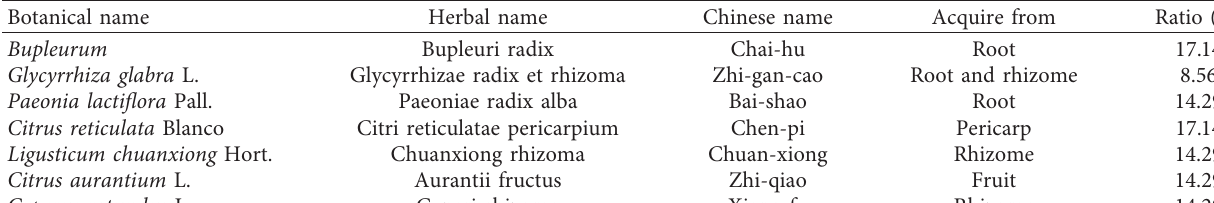
Table 1: The information of components in chaihu-shugan-san (CHSGS).